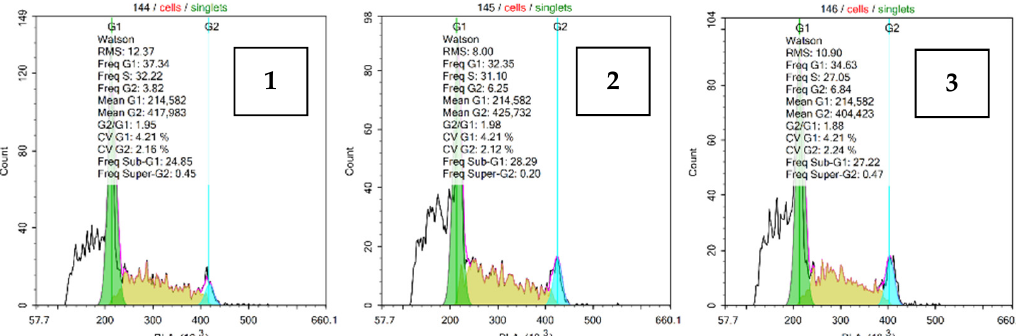
Figure 2. Effect of compound 24b on the cell cycle in Jurkat cells. Cells were analyzed using flow cytofluorometry. ( 1 ) 24c (0.02 µ М ); ( 2 ) 24c (0.05 µ М ); ( 3 ) 24c (0.1 µ М ). Data are presented as the means ± SEM calculated from results of at least four independent experiments. Statistically significant differences from the values in the control are indicated as p < 0.001.